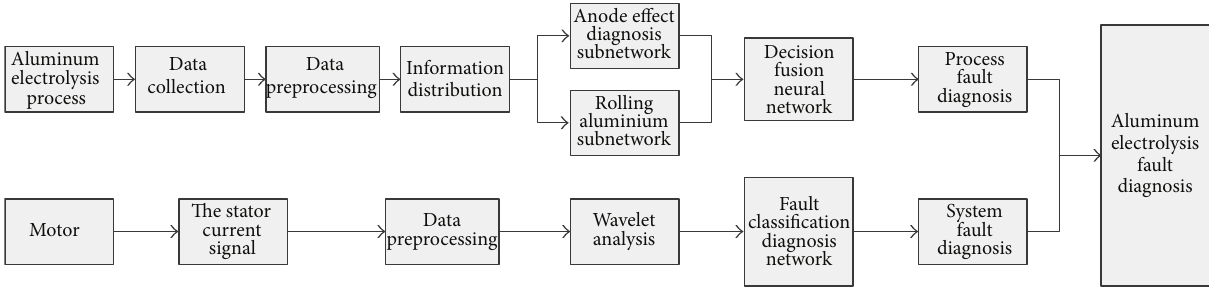
Figure 1: Aluminum electrolysis fault diagnosis system.